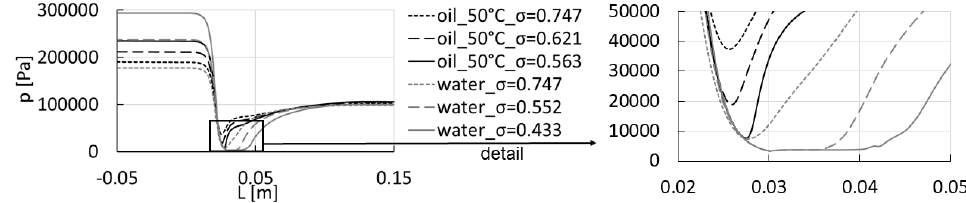
Figure 10. Dependence of pressure on the wall p vs. length L ; the detail is to the